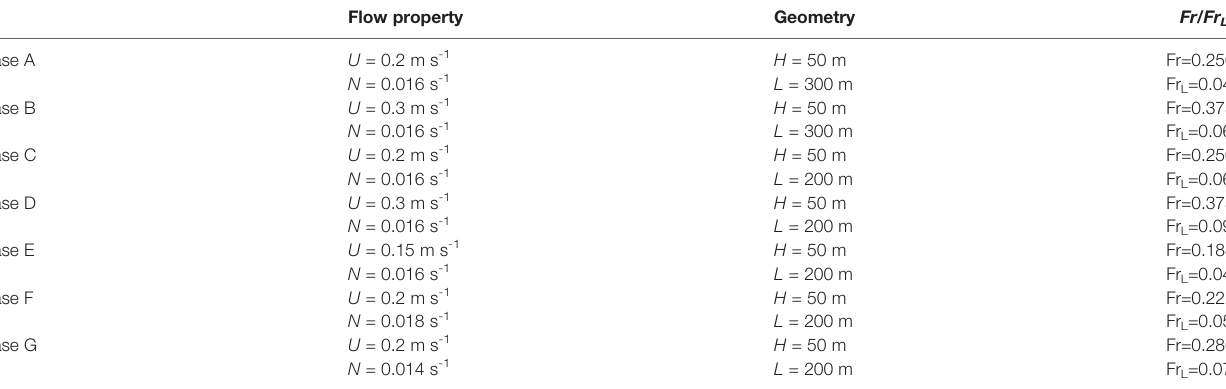
TABLE 1 | In this study, model experiments with different intensities of shear fl ows and background strati fi cation are conducted over narrow to wide